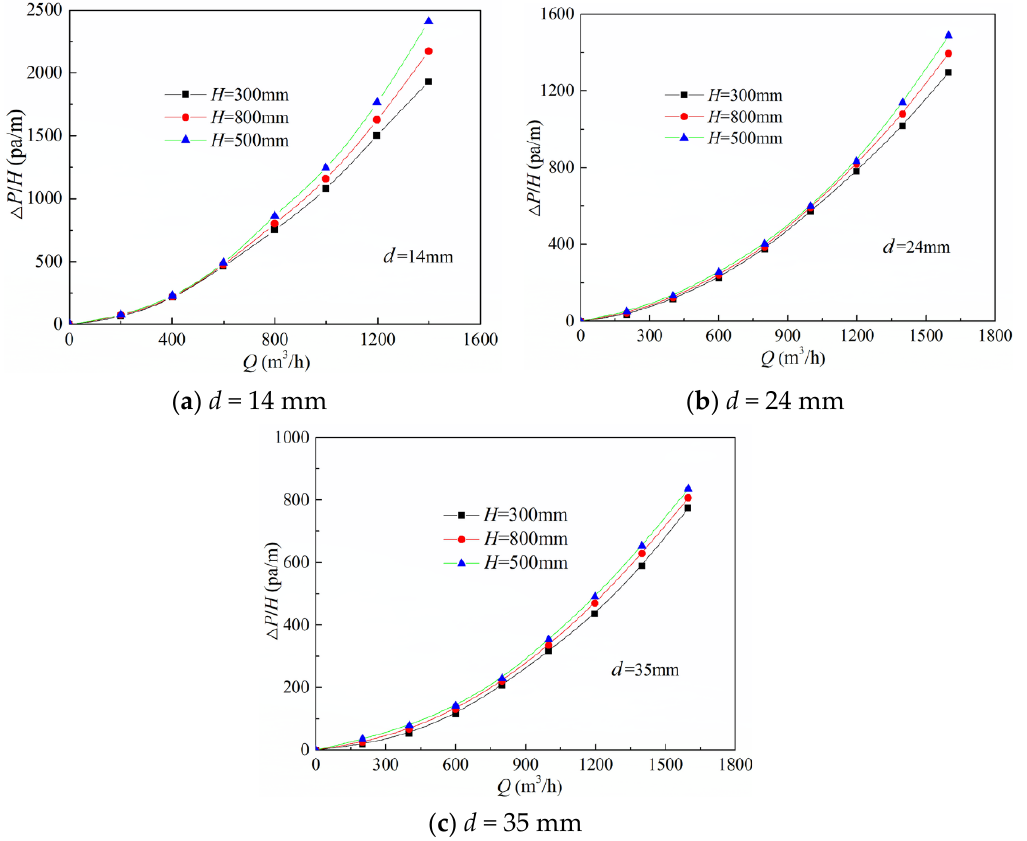
Figure 2. Changes of Δ P / H with Q under different BL heights and particle diameters [34].